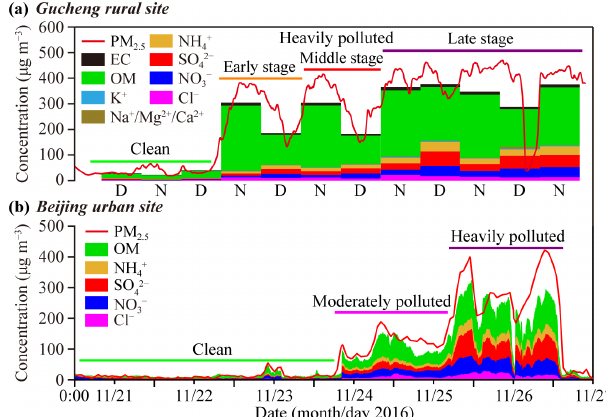
Figure 2. Time series of PM 2 . 5 and major aerosol chemical species at the (a) Gucheng rural site and (b) Beijing urban site. Chemical species were obtained by offline analysis of daytime (D) and night- time (N) PM 2 . 5 filter samples at the rural site and were obtained by online analysis of NR-PM 1 using a high-resolution aerosol mass spectrometer (HR-AMS) at the urban site. The different periods of the haze episode at rural and urban sites are marked in this